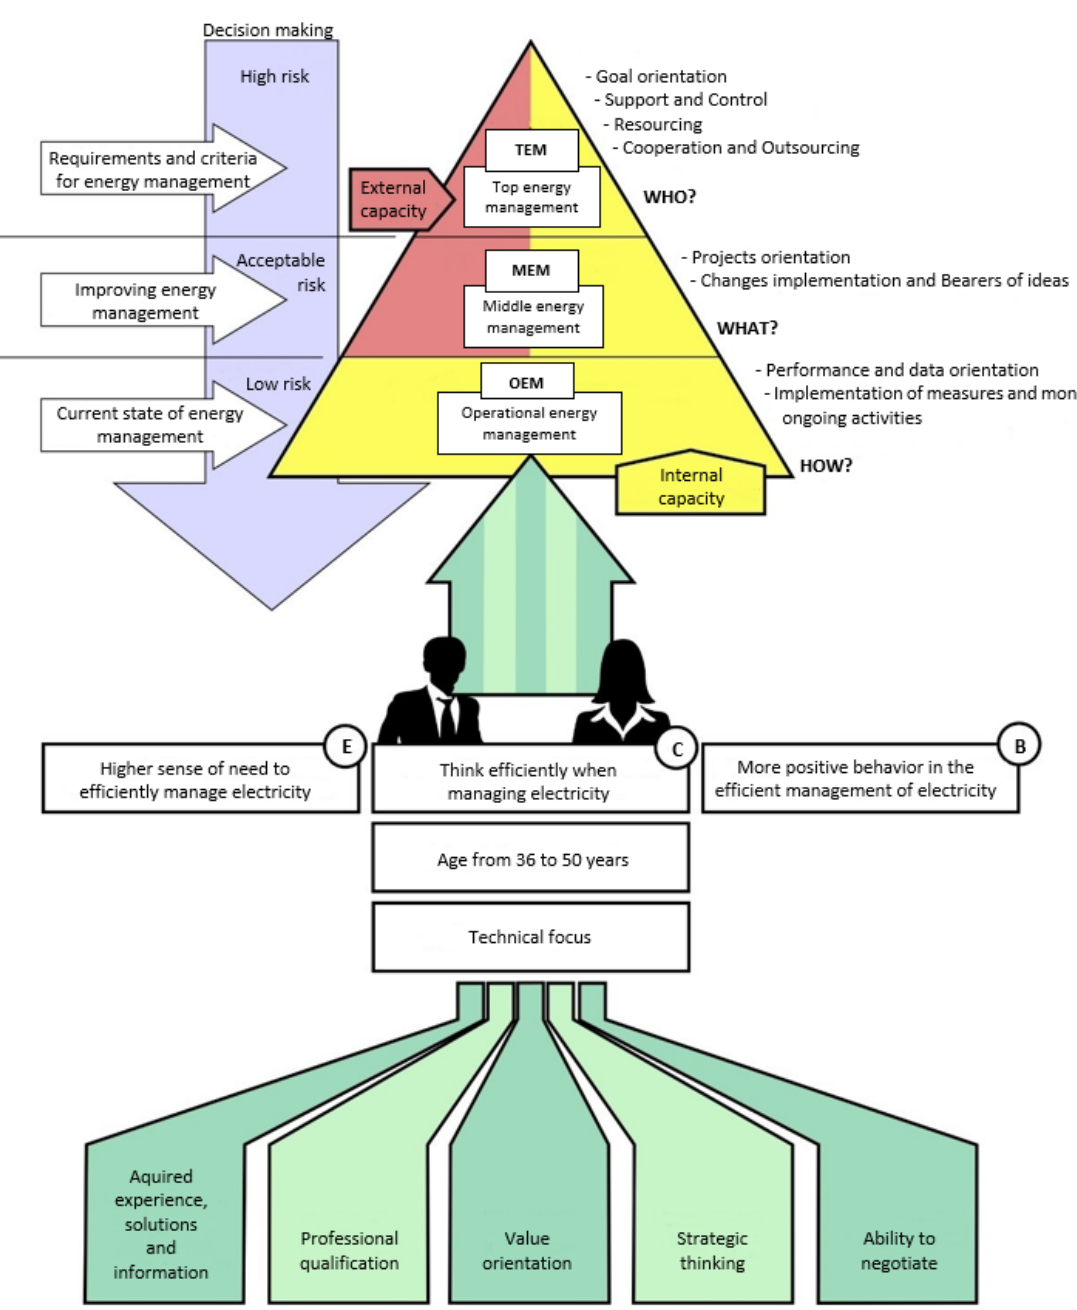
Figure 1. Design of a scheme for building energy management using own and external capacities.